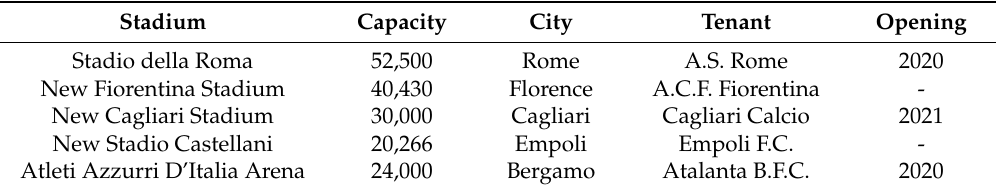
Table 2. List of the main stadium plans which have already been discussed by the local municipalities or which are under discussion at the moment